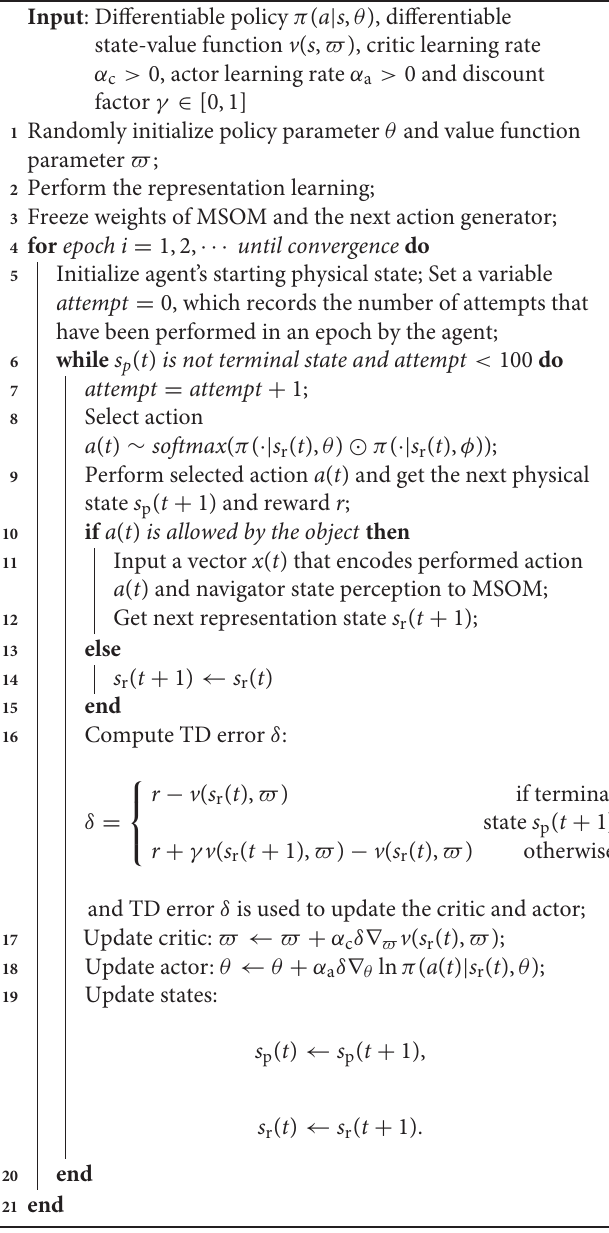
Algorithm 1: Articulated goal-oriented learning